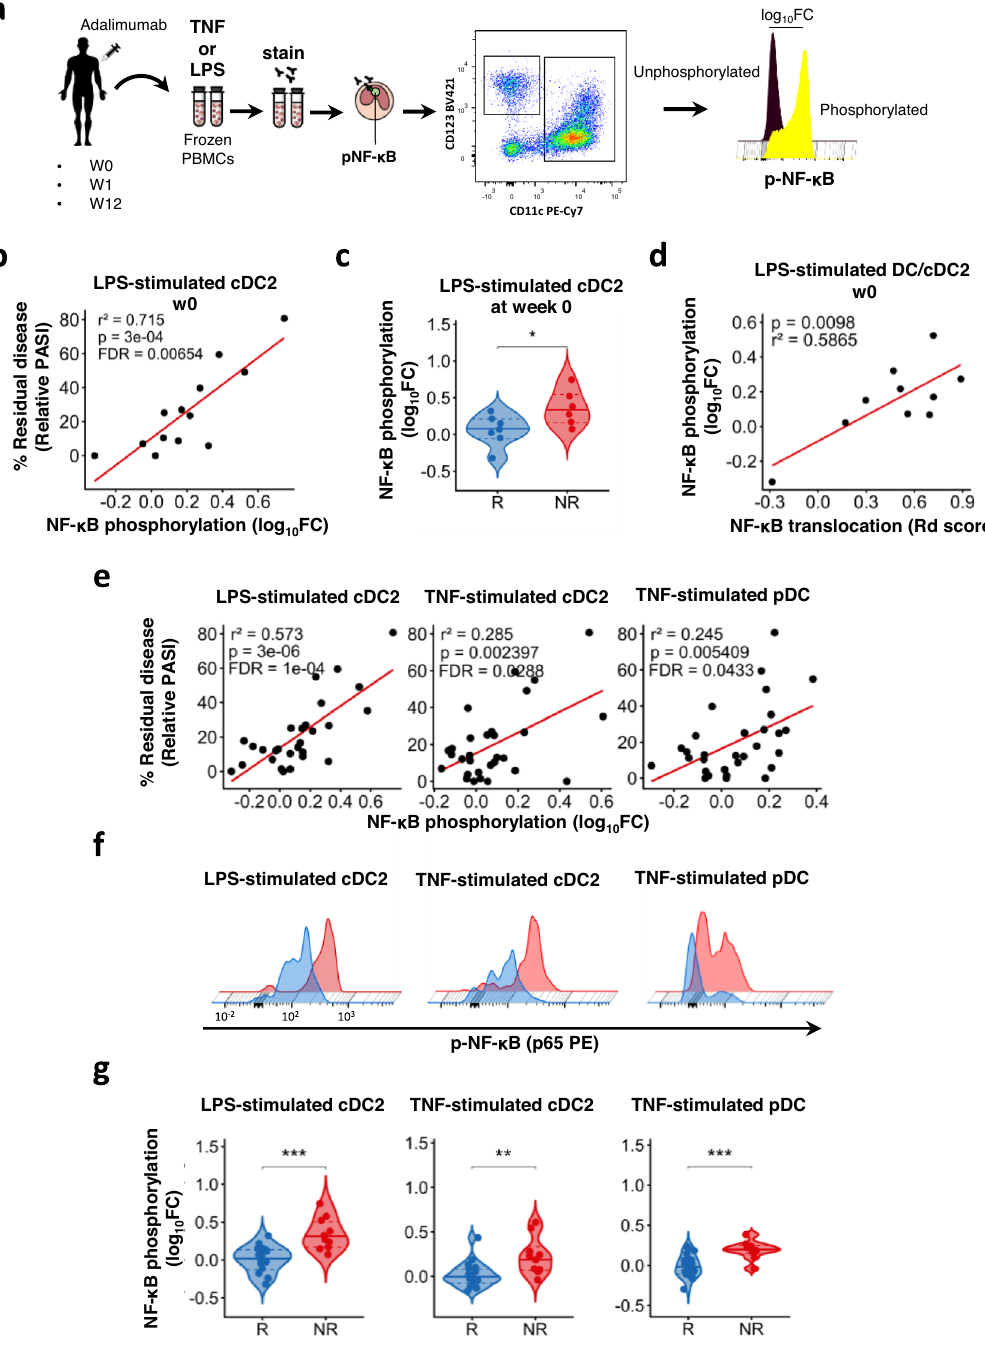
Fig. 2 LPS-induced NF- κ B phosphorylation in cDC2 at baseline correlates with response to adalimumab. a PBMC from psoriasis patients obtained at baseline (week 0, w0) and at w1 and w12 after starting adalimumab therapy were stimulated with either TNF or LPS and NF- κ B p65 phosphorylation was measured by phospho fl ow cytometry. b Correlation analysis between LPS-induced NF- κ B p65 phosphorylation (log 10 FC) in conventional Type 2 DC (cDC2) at w0 and clinical response, expressed as a residual disease at w12 and measured as relative PASI in the discovery cohort ( n = 13). Each dot represents one patient. c Violin plot graphs of LPS-induced NF- κ B p65 phosphorylation in cDC2 at w0 in PASI75 adalimumab responders PASI (R, blue, n = 7) and non-responders (NR, red, n = 6) * p = 0.035. d Correlation between LPS-induced NF- κ B nuclear translocation in DC and LPS-induced NF- κ B p65 phosphorylation in cDC2 at w0. e Correlation analyses between NF- κ B p65 phosphorylation induced by different stimuli in cDC2 and plasmacytoid Dc (pDC) and residual disease in the PSORT adalimumab combined cohort ( n = 25 – 30). f Representative phospho fl ow overlay histograms of NF- κ B p65 phosphorylation in DC subsets in PASI75 adalimumab responders (blue) and non-responders (red). g Violin plot graphs of NF- κ B p65 phosphorylation induced by various stimuli in DC subsets in PASI-75 adalimumab responders (blue, n = 16 – 20) and non-responders (red, n = 9 – 10) ( p cDC2- LPs = 0.00056, p cDC2-TNF = 0.013, p pDCs-TNF = 0.00034). p values and FDR are reported on the graph in ( b ), ( d ) and ( e ); Mann – Whitney U test ( c , g , left and right panels) or unpaired t test ( g middle panel). All tests are two-sided. Source data are provided as a Source Data fi